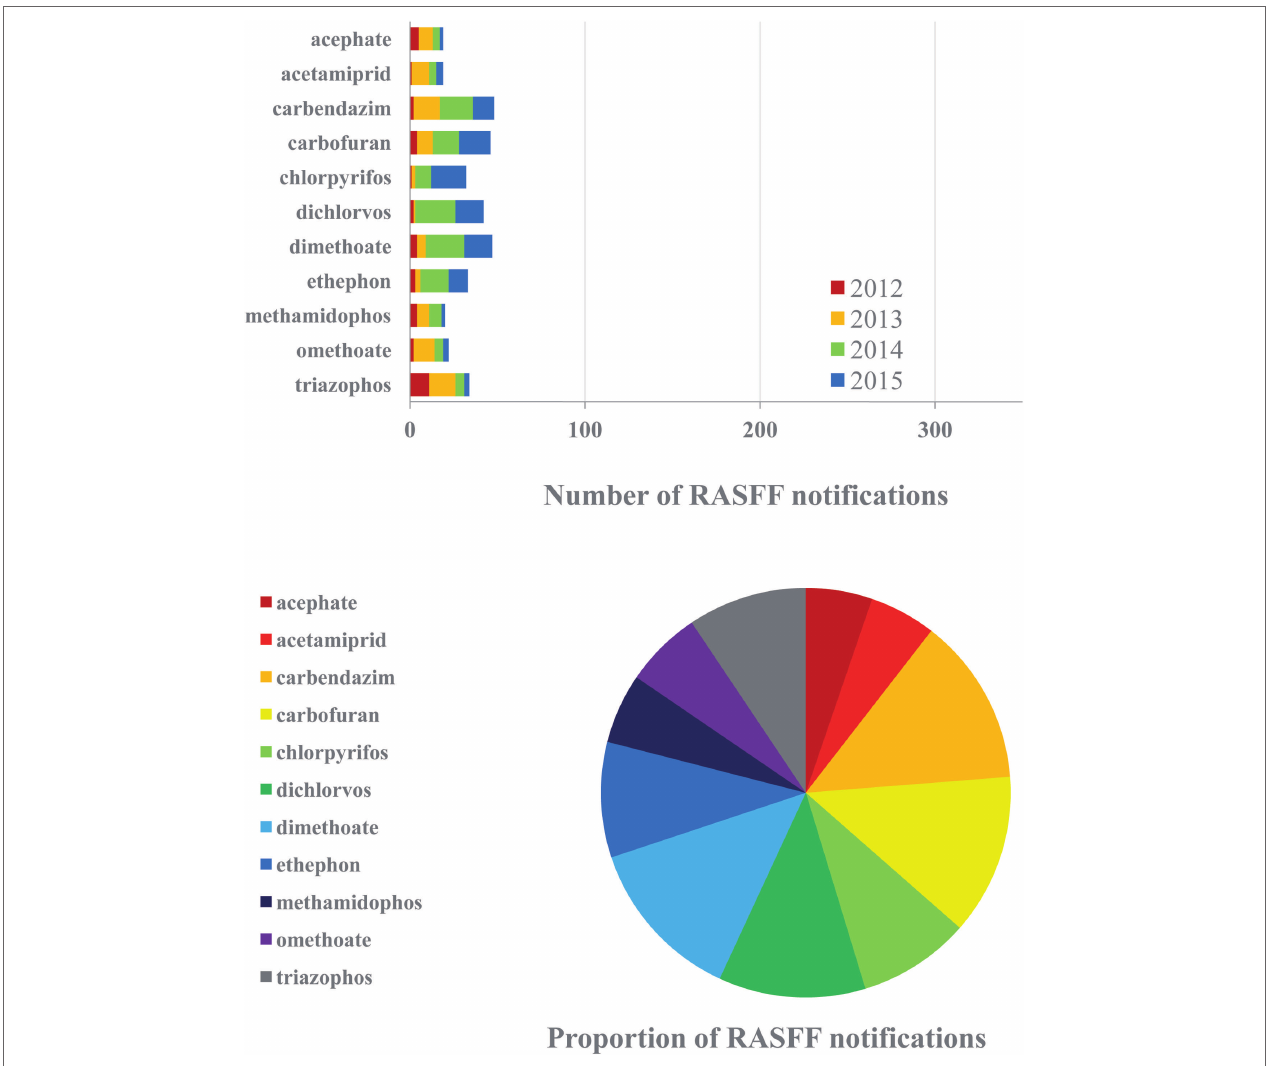
FiGURe 3 | Frequently reported active ingredients of plant protection product (PPP) residues in the Rapid Alert System for Food and Feed (RASFF) database in the corresponding critical period, 2012–2015 (above). Proportions of the PPPs reported during the 4-year period